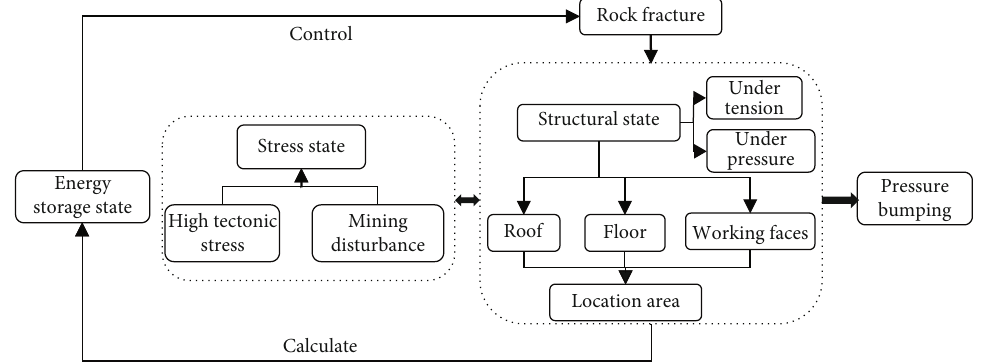
Figure 1: Relationship between stress, structure, area, and rock burst in mines.